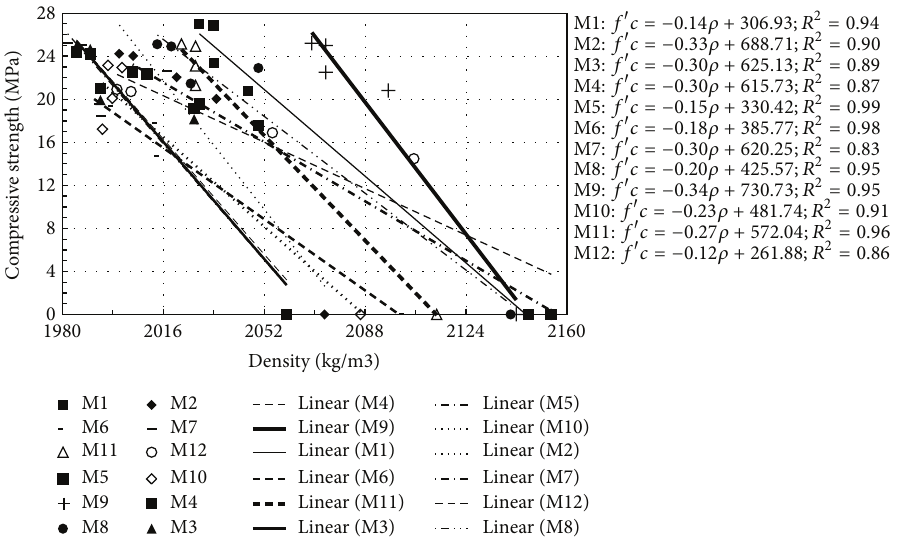
Figure 5: Relationship between density and compressive strength at different ages of mortar mixes.